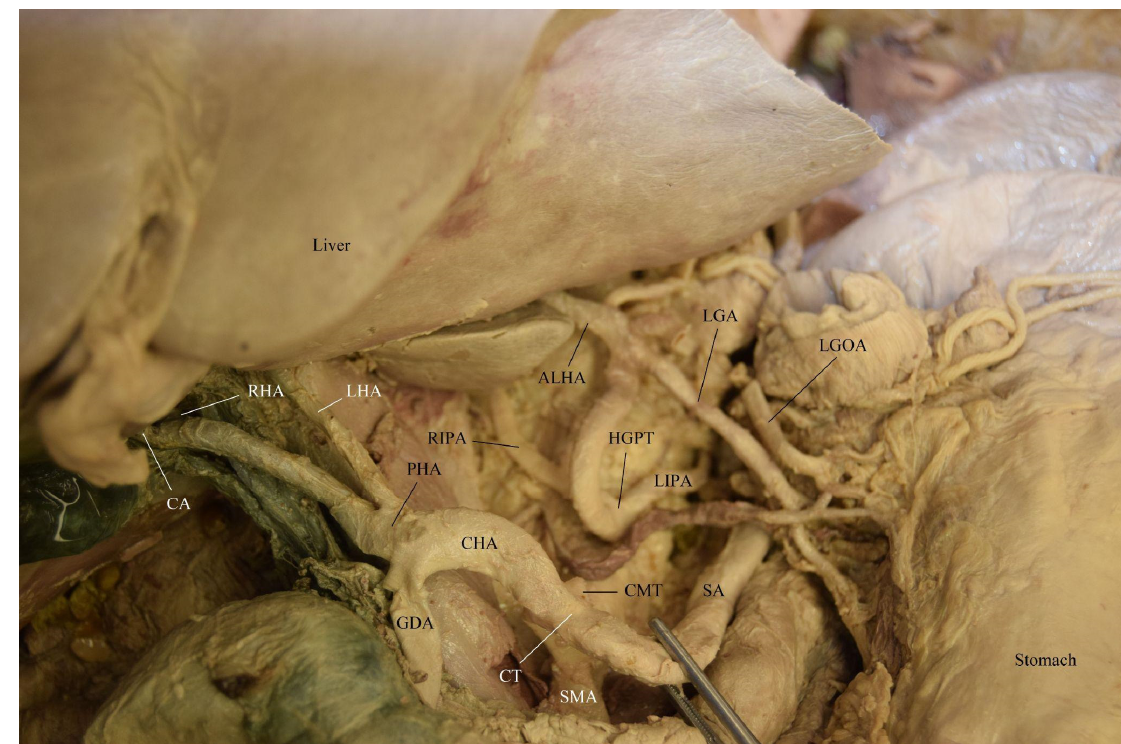
Figure 2. Arterial vasculature of the hepatogastrophrenic trunk (HGPT) and the celiac trunk (CT) of the celiacomesenteric trunk (CMT).